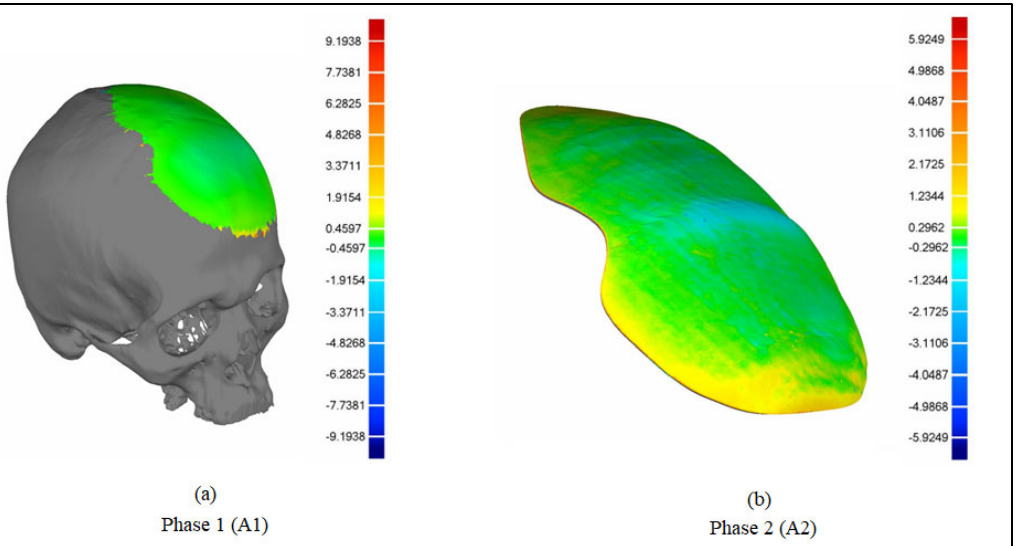
Figure 13. Deviation in the outward direction. ( a ) Healthy skull and the designed implant (virtual model); ( b ) designed implant (virtual model) and the fabricated implant.